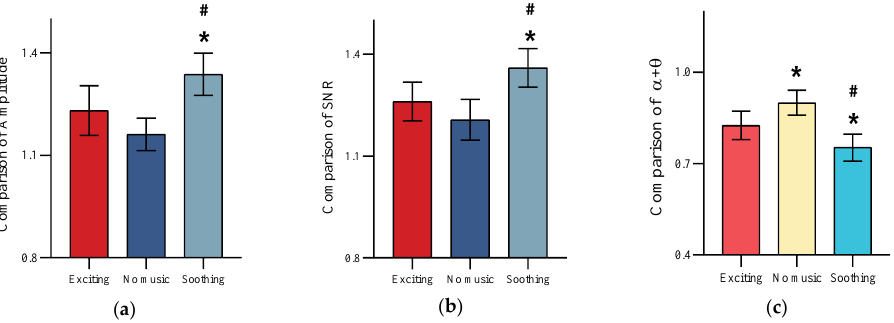
Figure 8. Comparison of variations in SSVEP amplitude, SNR, and EEG power index α + θ under different background music modes. ( a ) Comparison of Amplitude. ( b ) Comparison of SNR. ( c ) Comparison of α + θ . *: Significant difference from exciting Music mode. #: Significant difference from no Music mode.